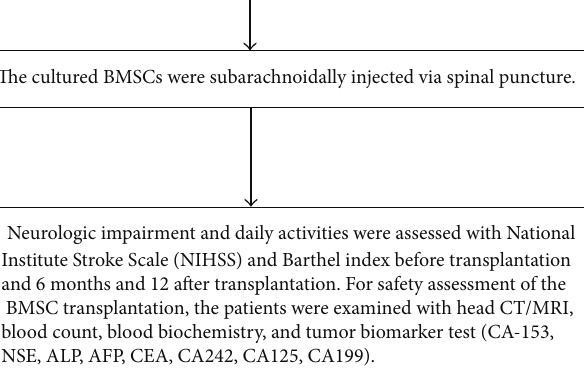
Figure 2: Flow diagram of the procedures of the surgery and the monitoring process of the safety and efficacy of